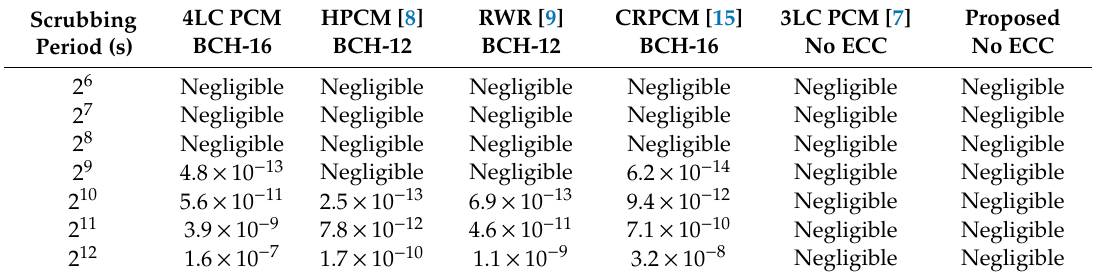
Table 6. Comparison of 512-bit cache line LERs between proposed method and previous studies.